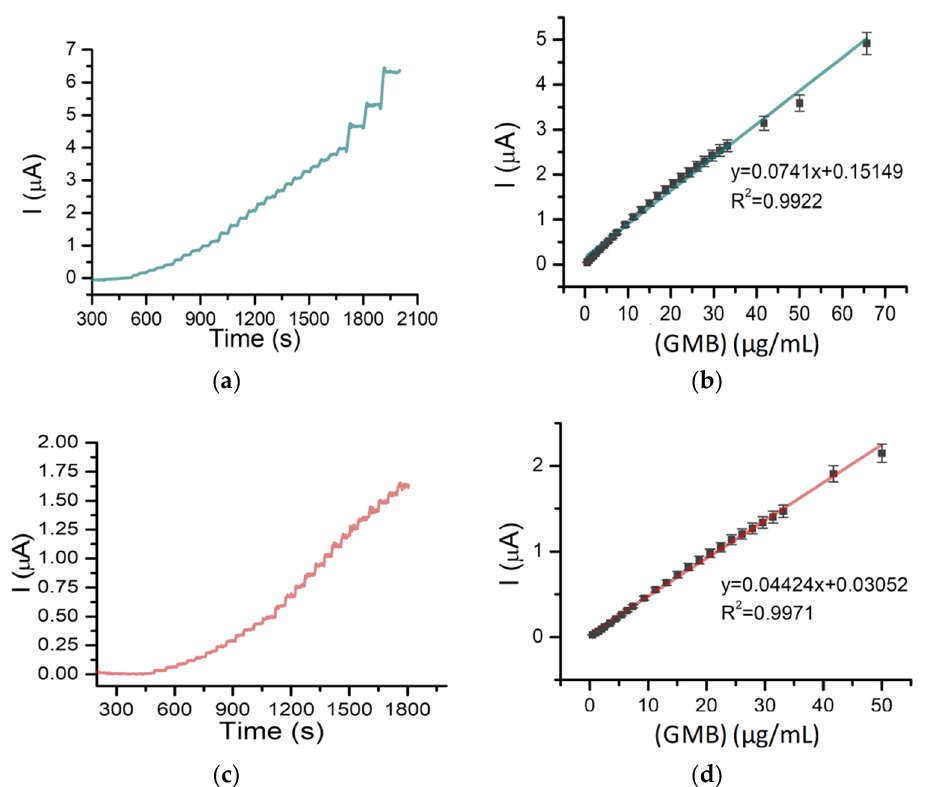
Figure 4. ( a ) Chronoamperogram of successive additions of different volumes of 500 μg/mL GMB solution (5 × 5 μL, 5 × 10 μL, 14 × 20 μL, 2 × 100 μL and 1 × 200 μL) in PBS (pH 7.4; 0.05 M) on BDDE.